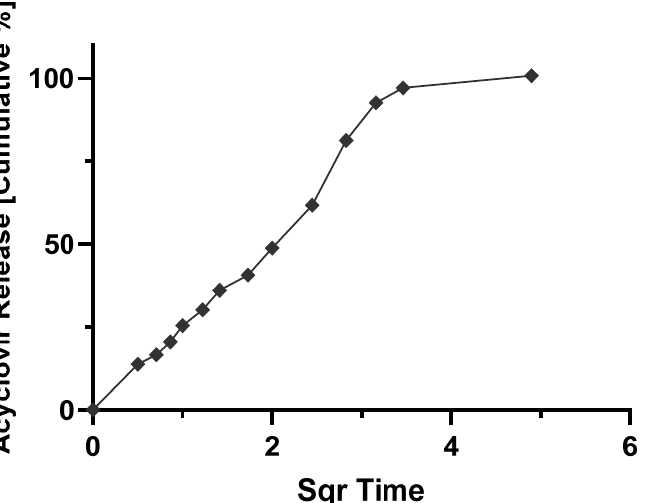
Figure 7. Cumulative percentage of acyclovir released from F2 formulation as a function of square route of time fitted to Higuchi kinetics ( y = 24.137 x + 2.2932; R 2 = 0.9412).